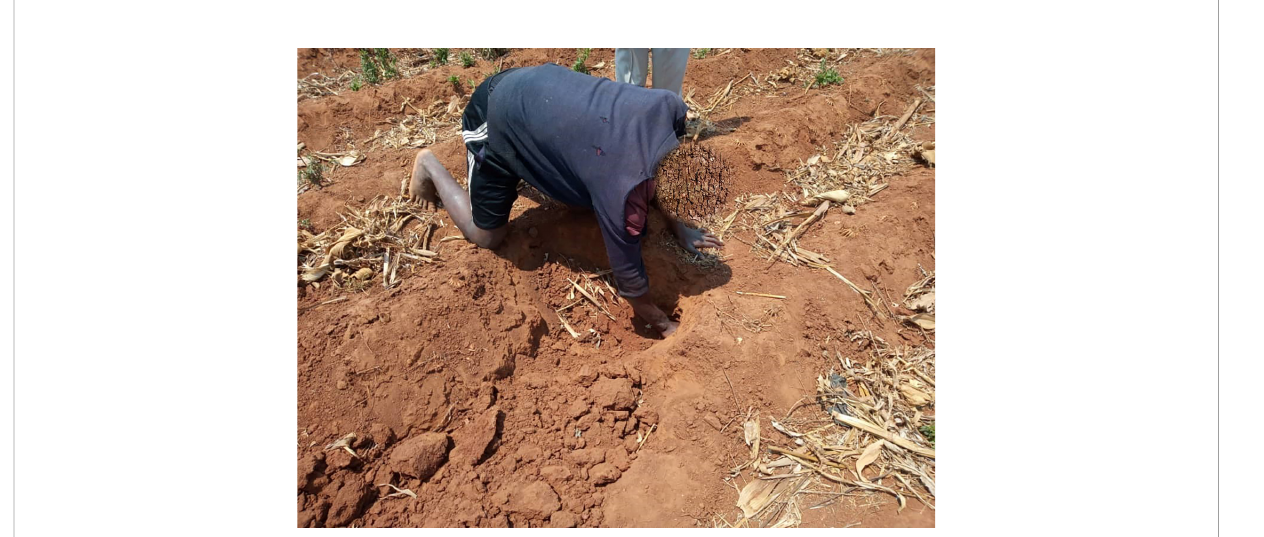
FIGURE 1 A “ mouse-hunter ” searching for rodents in a suspected burrow in a maize fi eld in